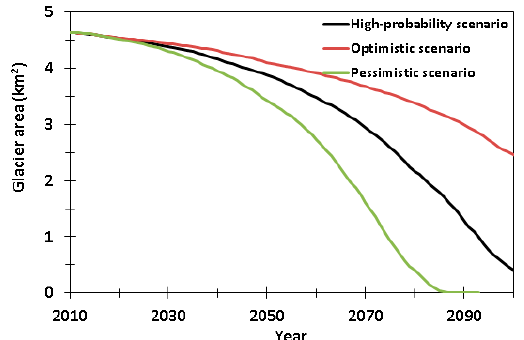
Figure 8. Simulated glacier areas as a function of time under three hypothetical climate scenarios, 2010~2100.